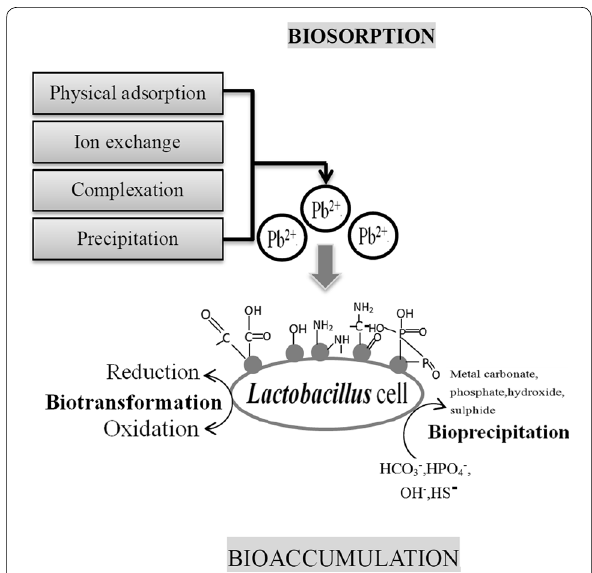
Fig. 5 The mechanism of biosorption and bioaccumulation of a microbial